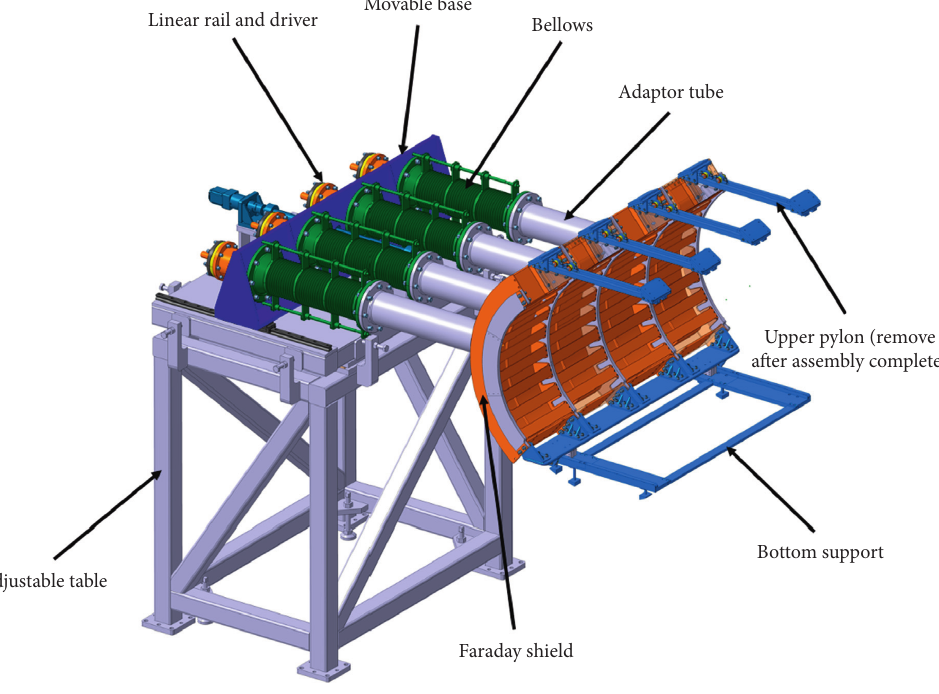
Figure 1: Brief sketch of the whole antenna system.